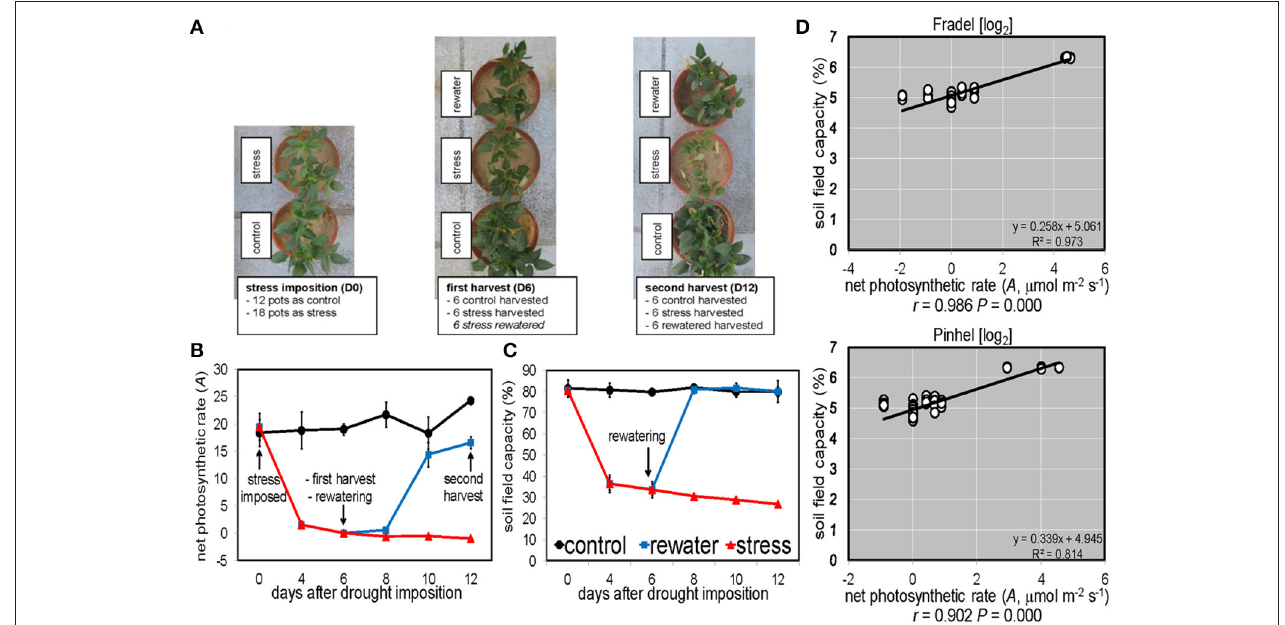
FIGURE 1 | Experimental layout and sampling scheme. (A) Top view of representative Pinhel plants at key points during the experiment. (B) Vegetative plants were harvested on day 6 (net photosynthetic rate A = 0 in stressed plants) and reproductive plants on day 12 ( A = control). (C) Forty-day-old control plants were maintained at 80% field capacity. Stressed plants were not watered for 6 days, when a cohort was rewatered ( n = 6 with two plants per pot; error bars = SD). (D) Logarithmic scaling of the relationship between field capacity and A of plants exposed to water deficit from day 0 until 12. R 2 , coefficient of determination; r , Pearson correlation coefficient; P , probability. Another set of plants ( n = 4) was grown till grain maturity (day